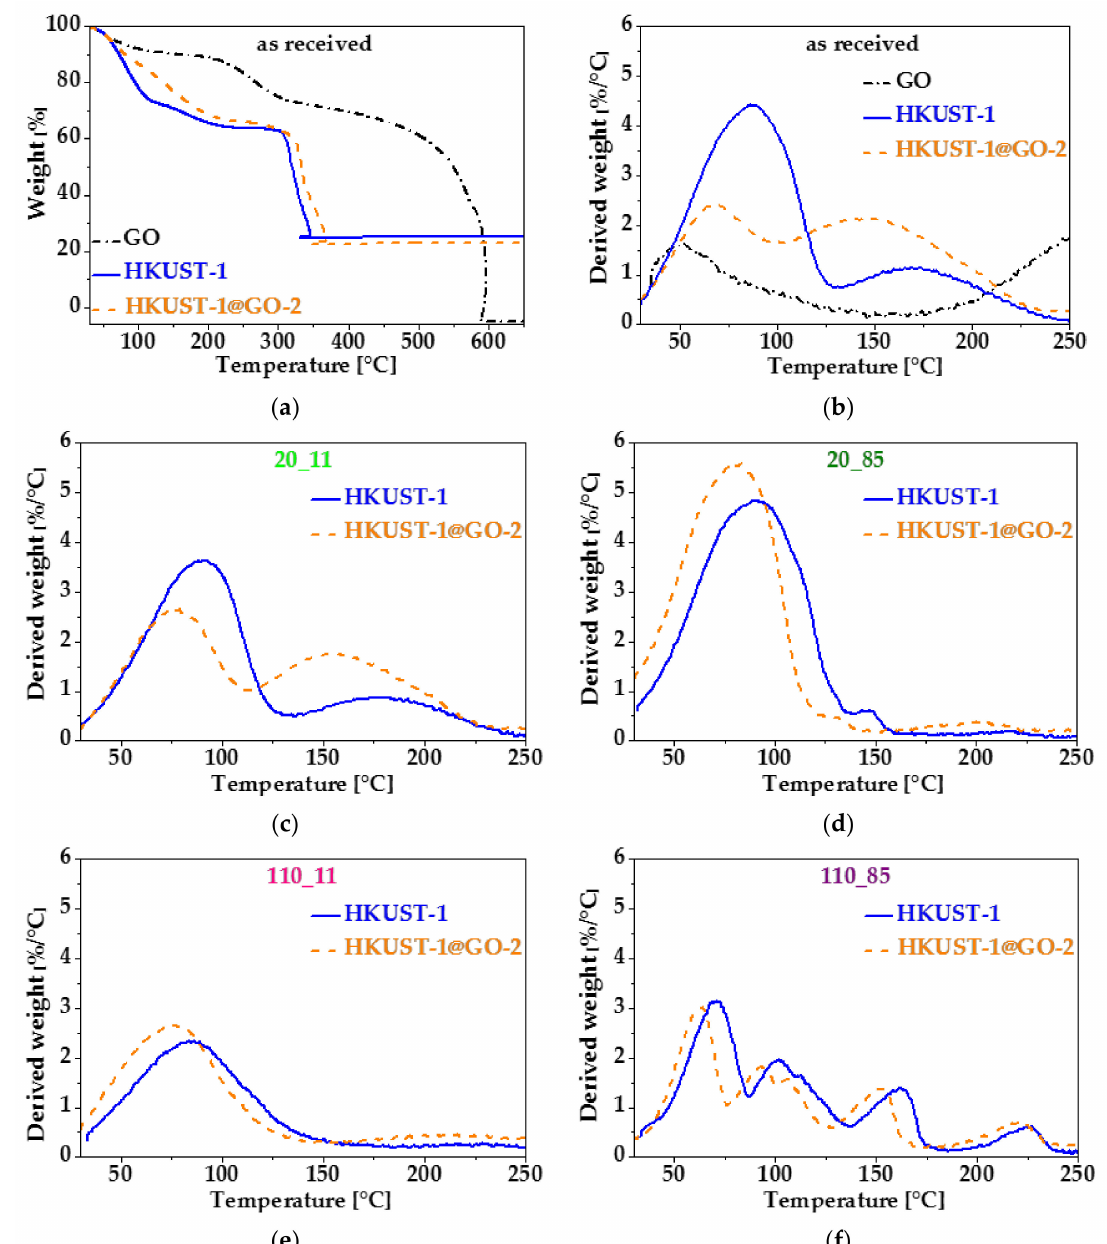
Figure 7. Comparison of the ( a ) weight loss (TG) and ( b ) corresponding derivative (weight loss rate, DTG) curves in the water loss region of parent and composite materials: GO (black, dash-dot), HKUST-1 (blue, solid), HKUST-1@-GO-2 (orange, dashed). DTG curves focusing on the water loss region of air-dried samples after exposure to ( c ) relative humidity (RH) 11% and ( d ) RH 85%. HKUST-1 and activated samples after exposure to ( e ) RH 11% and ( f ) RH 85%. Thermal analysis was carried out